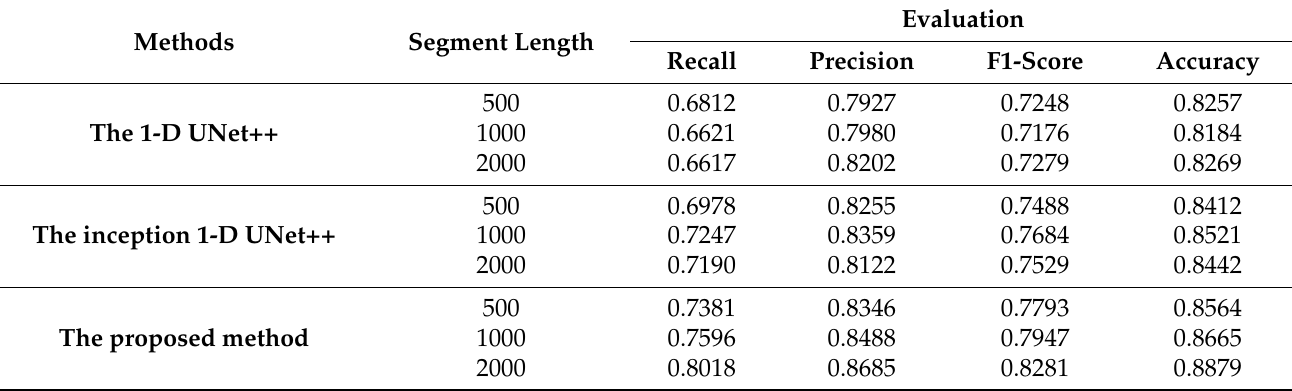
Figure 4. Performance graphs of the proposed model. ( a ) The RR segment length N = 500; ( b ) The RR segment length N = 1000; ( c ) The RR segment length N = 2000. Table 2. The overall performance with different length of RR